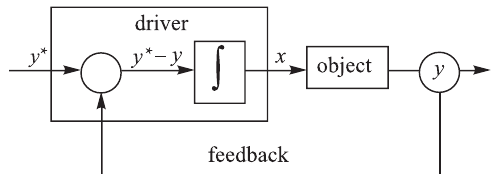
Fig. 3. Scheme of control synthesis cycle “The Control